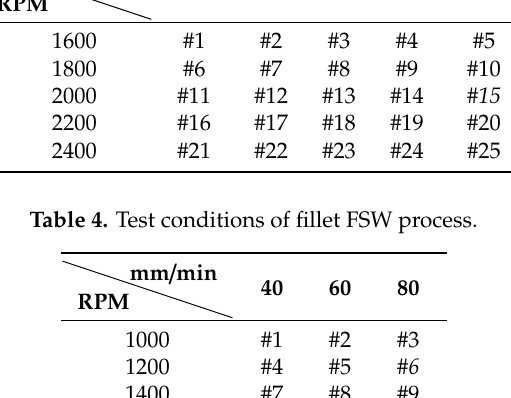
Table 3. Test conditions of butt FSW process.